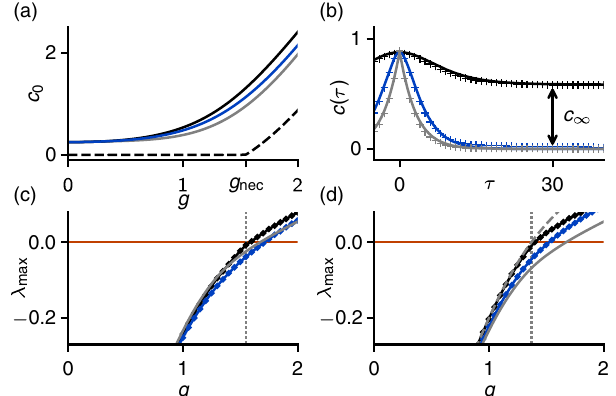
FIG. 4. Effect of correlation time of the input on the transition to 2 , and chaos. The cases of white-noise, colored noise with τ n ¼ quenched input correspond to the curves shown in gray, blue, and black, respectively. (a) Self-consistent variance c 0 depending on the coupling g . At vanishing coupling, the inputs are chosen such that c 0 ¼ σ 2 ¼ 0 . 25 is identical in all three cases of white, colored, and quenched noise. Resulting dynamic contribution c 0 − c ∞ (dashed black curve) of the variance in the case of quenched noise. (b) Self-consistent autocorrelation function (solid curves) compared to simulations (crosses) for g ¼ 1 . 5 . The ampli- tude of colored and quenched noise is adjusted to obtain the same variance (peak height) as for white noise. (c) Maximum Lyapunov exponent as a function of g for colored and quenched noise measured in simulations (diamonds connected by lines) compared to white noise (identical to Fig. 3(a) with σ ¼ 0 . 5 ). (d) Same as in panel (c) but for identical variance c 0 for each value of g . Gray curves correspond to the Lyapunov exponent (solid) and the upper bound (dashed) from the white-noise case. The necessary condition (18) is marked as a gray dotted vertical line in panels (c) and